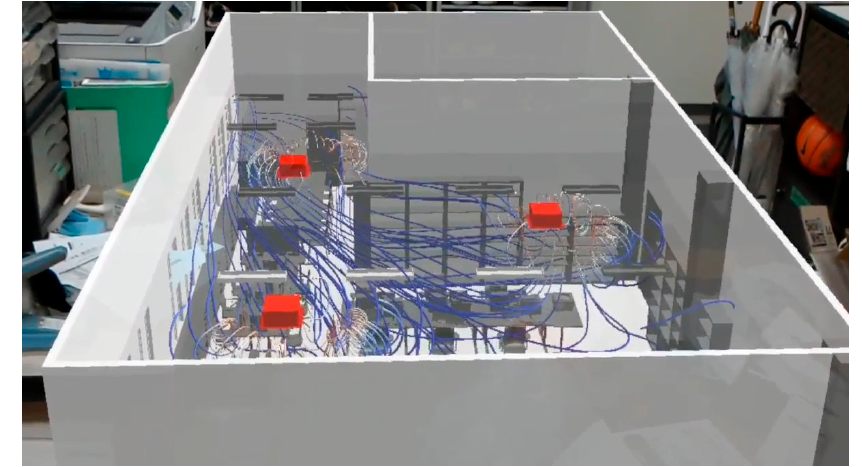
Figure 3. HMD view of room 411 small-scale model (1/10) using computational fluid dynamics (CFD) results.